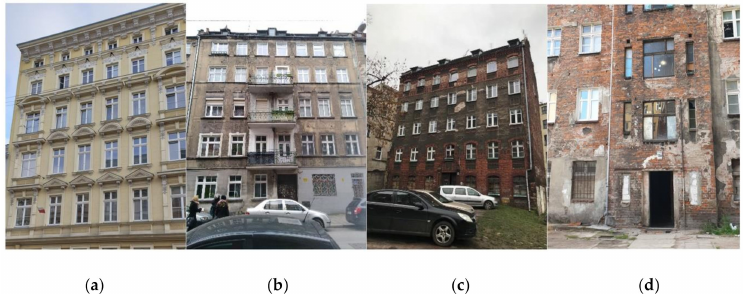
Figure 1. Four specified technical conditions of tenement houses in Wroclaw (according to Table 1 and